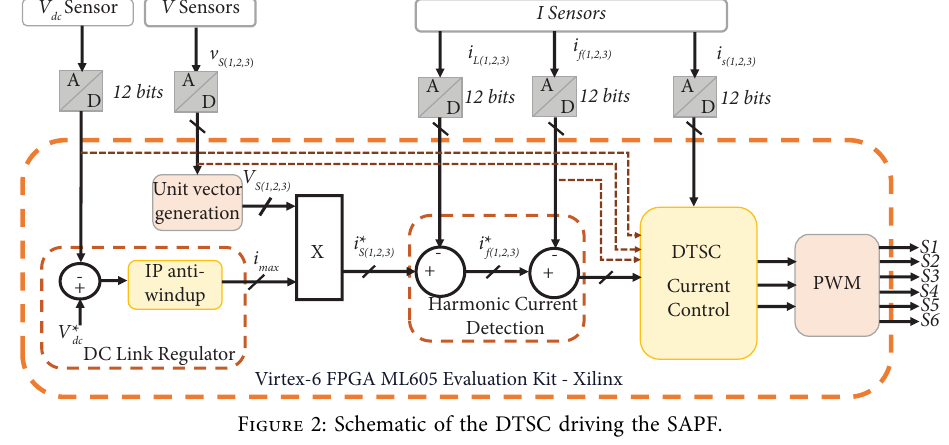
Figure 2: Schematic of the DTSC driving the SAPF.